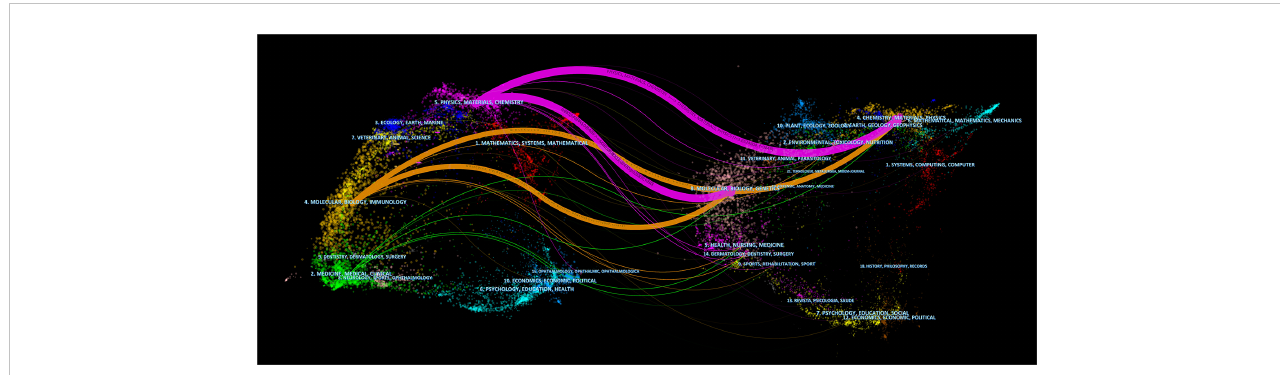
FIGURE 7 The dual-map overlay of journals contributed to publications regarding nanomaterials for diabetic wound healing from 2011 to